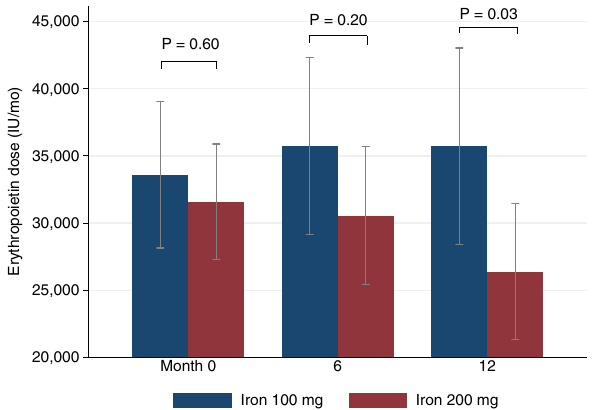
Figure 2. Mean monthly dosages of erythropoietin at month 0 (baseline), month 6, and month 12 (primary endpoint) between 100 and 200-mg intravenous iron groups. The bars indicate 95% confidence intervals. The